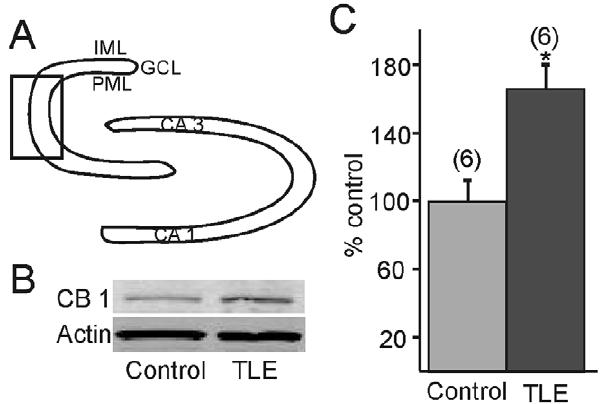
Figure 8. Western blot detection of cannabinoid type 1 receptor (CB1R) expression. A . Diagram of dentate gyrus illustrating the area that was micro-dissected (box) for analysis. B . Western blot showing CB1R expression in pilocarpine-treated mice that survived SE and developed TLE compared to untreated mice. Actin was used as the loading control, which did not change significantly. C . Graph showing cumulative (60%) increase in CB1R expression in mice with TLE versus controls (n=6; p , 0.05). * indicates significance. IML, inner molecular layer; GCL, granule cell layer; PML, polymorphic layer.